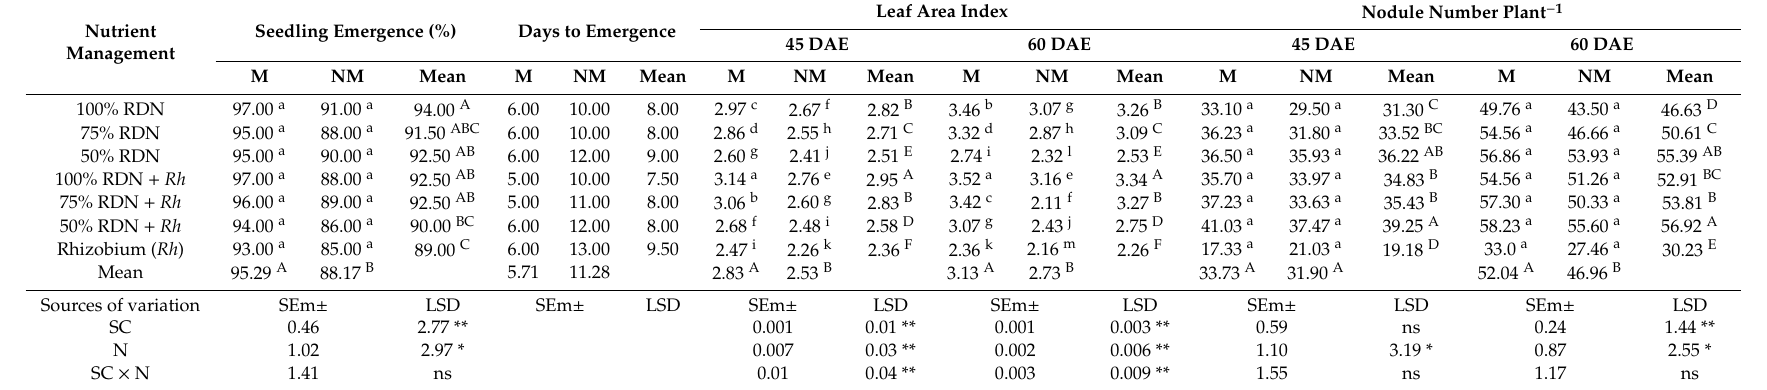
Table 1. E ff ect of soil mulch and nutrient management on peanut growth attributes in 2015–2016.